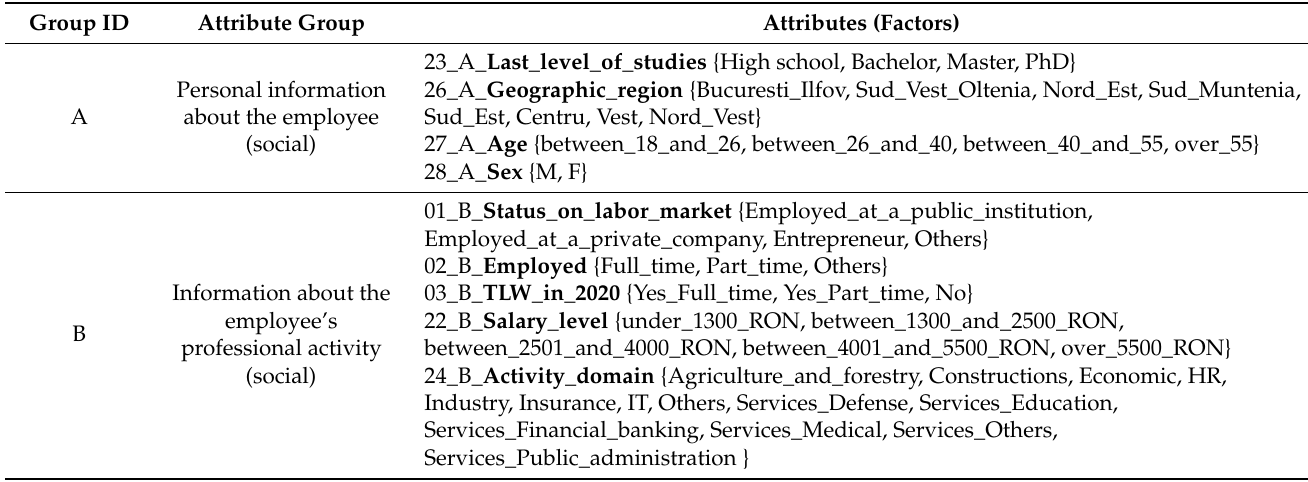
Table A1. Attributes groups